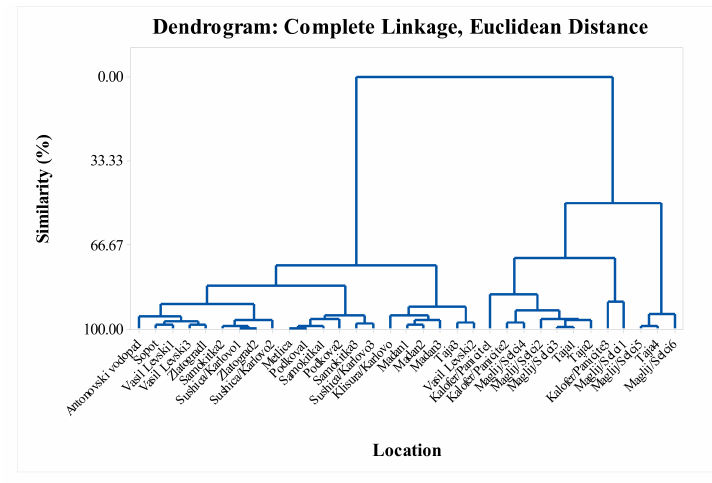
Figure 7. Complete linkage dendrogram showing the similarity of 33 locations in terms of carvacrol and p -cymene of Satureja pilosa .